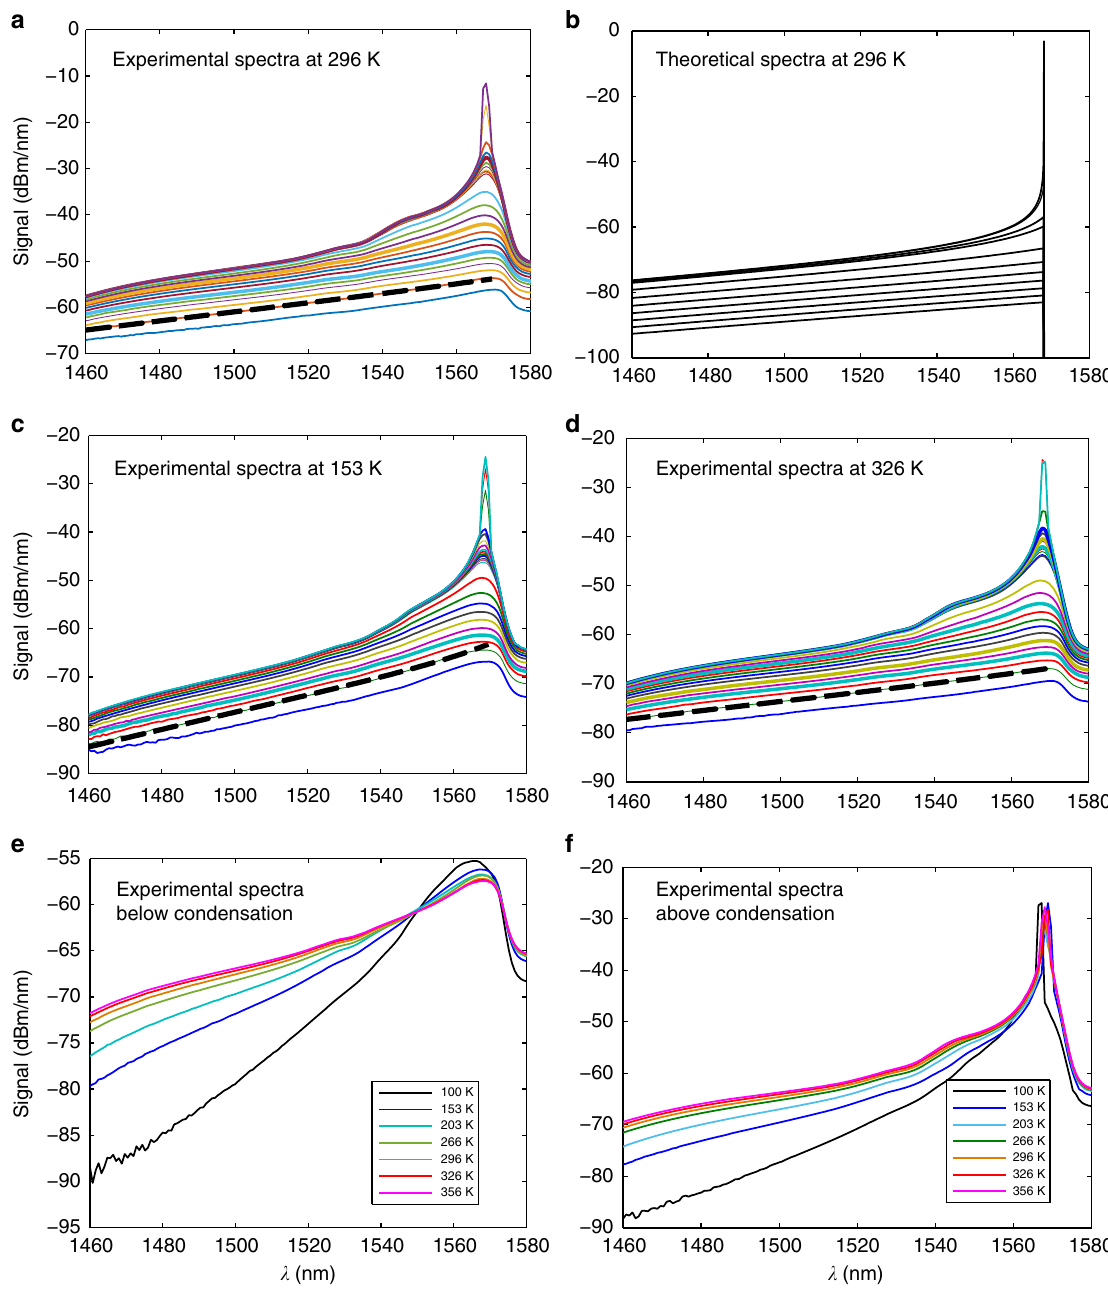
Fig. 2 Experimental and theoretical spectra below and above condensation. They are given for different overall powers (photon density) P and temperatures T . The slopes of the almost straight lines in the spectra ( λ dependence of h ν / k B T ) fi t the theoretical thermal Bose – Einstein (BE) distribution slope for each temperature shown by the dashed lines. a Experimental spectra at a room temperature (296 K) for various intra-cavity power P values. b Theoretical BE distribution at a room temperature. c Experimental spectra at 153 K. d Experimental spectra at 326 K. The different power P values for the spectra in a , c , d are obtained by increasing the pumping from 0 to 80 μ W. e , f show the spectra for various temperatures, each with a fi xed power, below and above condensation ( P = 1.4 and 80 μ W, respectively). We emphasize that the slopes match the various temperatures following the